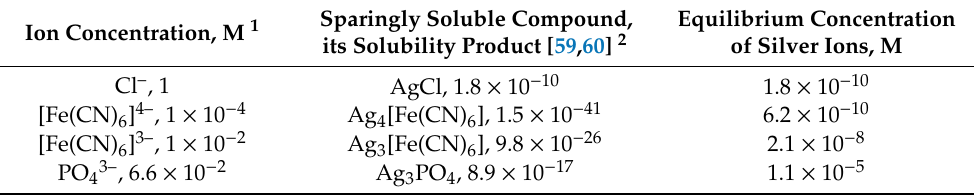
Table 1. The equilibrium concentration of silver ions over solutions of sparingly soluble compound. Sparingly Soluble Compound, Equilibrium Concentration Ion Concentration, M 1 its Solubility Product [59,60] 2